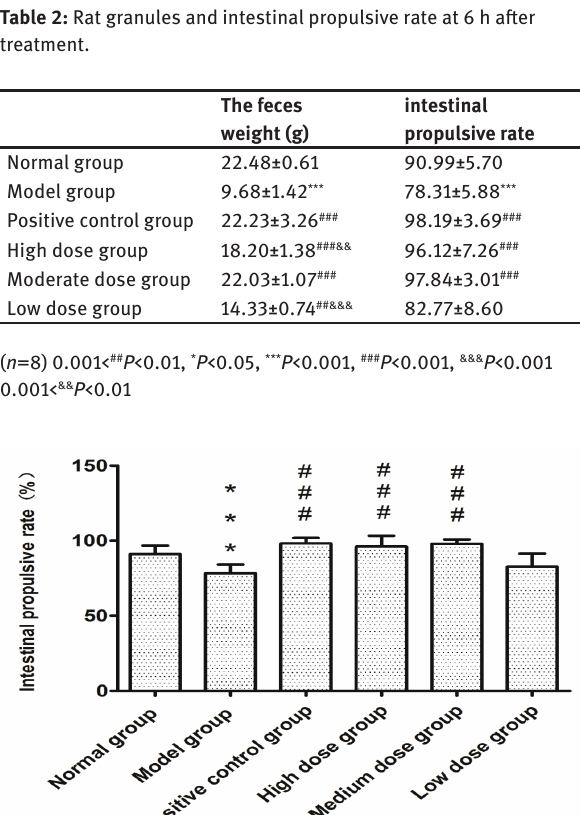
Fig. 4b The body weight of rats for 6 h